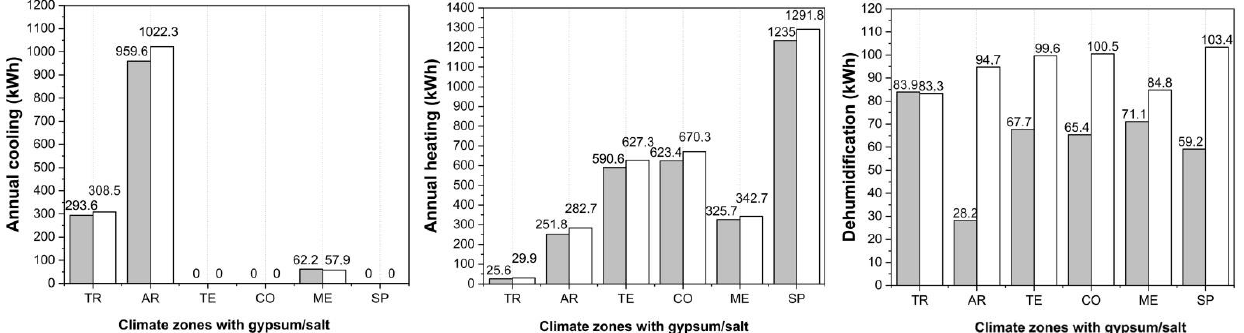
Figure 7. Comparison of annual cooling, heating, and dehumidification demand for gypsum and Figure 7. salt in six climate zones (TR—Tropical, AR—Arid, TE—Temperate, CO—Continental,